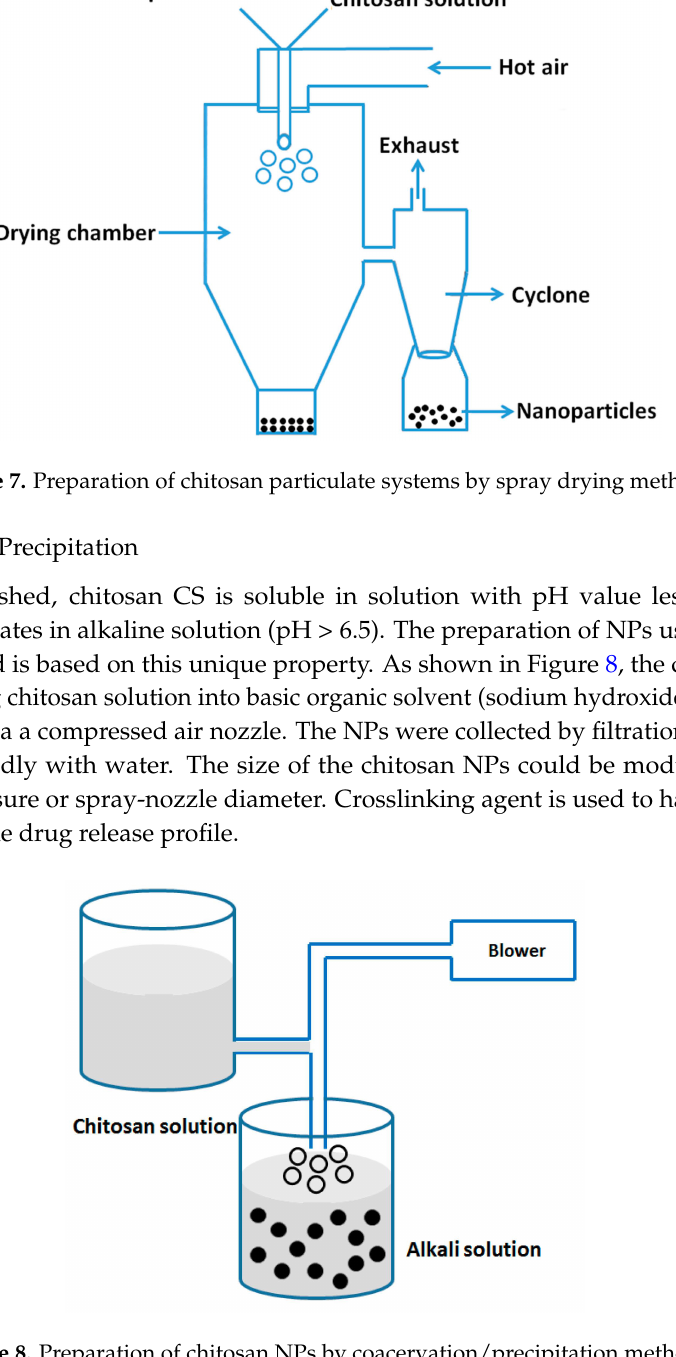
Figure 8. Preparation of chitosan NPs by coacervation/precipitation